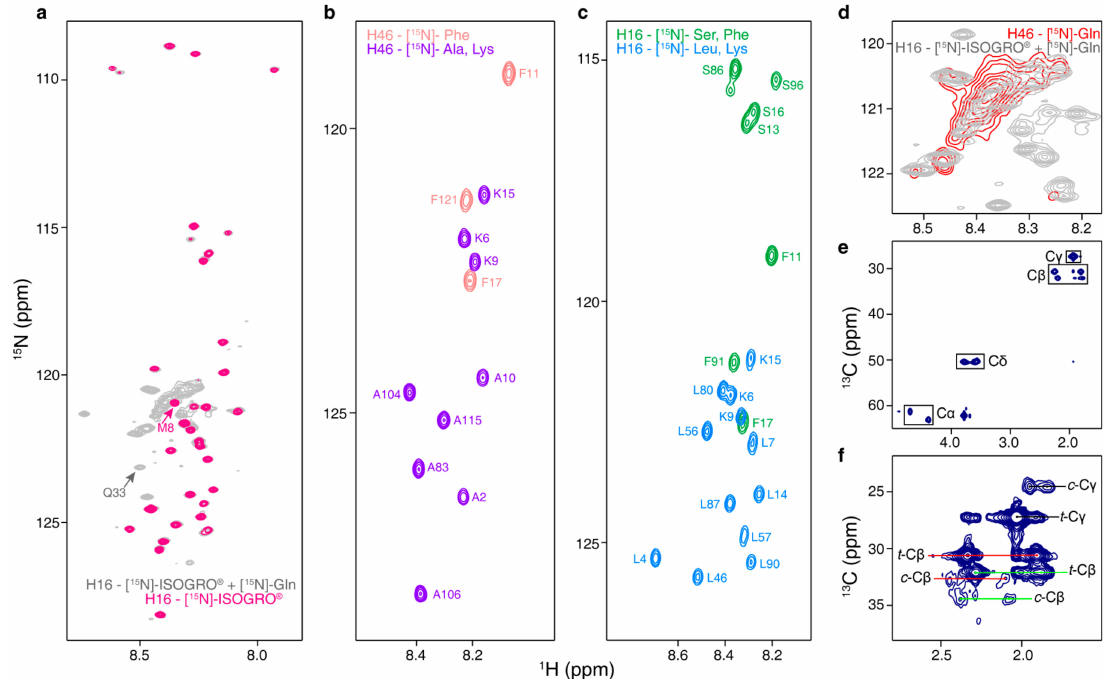
Figure 5. Isotopic labeling strategies for the NMR investigation of HttEx1. ( a ) Overlay of the 15 N-HSQC spectra of H16 samples expressed using [ 15 N]-ISOGRO ® in the absence (pink) or presence (gray) of [ 15 N]-Gln, as shown previously in [25]. ( b,c ) 15 N-HSQC spectra of selectively labeled H46 ( 15 N-Phe and [ 15 N]-Ala / [ 15 N]-Lys) and H16 ( 15 N-Ser / 15 N-Phe and [ 15 N]-Leu / [ 15 N]-Lys) samples, respectively. ( d ) Zoom of the Gln region of 15 N-HSQC spectra of fully labeled H16 and exclusively [ 15 N]-Gln -labeled H46. ( e ) 13 C-HSQC spectra of an H46 sample exclusively labeled with [ 15 N, 13 C]-Pro. ( f ) Zoom of the 13 C-HSQC from panel ( e ), highlighting the correlations of the cis and trans conformations of C γ -H γ (black) and of the two proline families observed for C β -H β , Pro- Pro (red) and Pro- Xaa